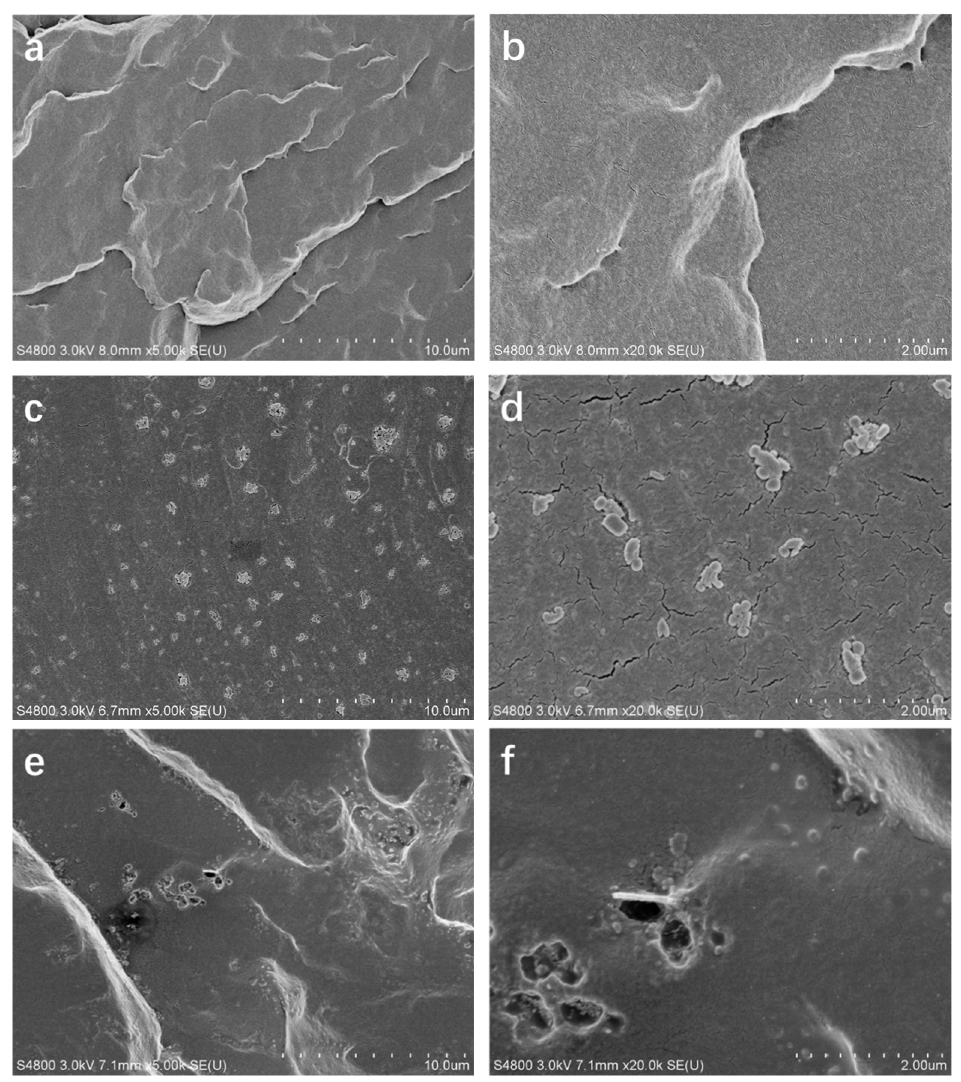
Figure 8. ( a ) SEM image of WPU; ( b ) enlarged SEM image of WPU; ( c ) SEM image of G/WPU; ( d ) enlarged SEM image of G/WPU; ( e ) SEM image of BP/G/WPU; and ( f ) enlarged SEM image of BP/GWPU.